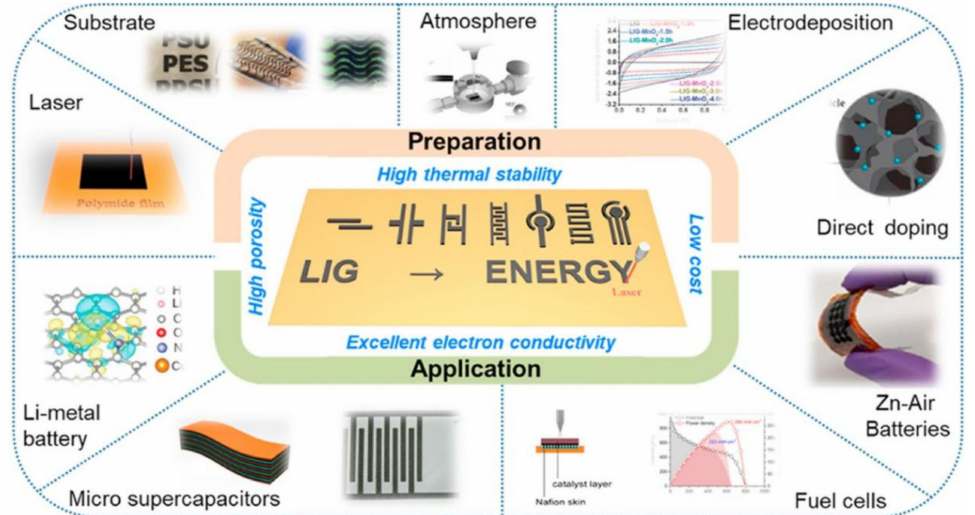
Figure 3. Illustration of the use of laser-induced graphene (LIG) for different applications [97]. Copyright 2020